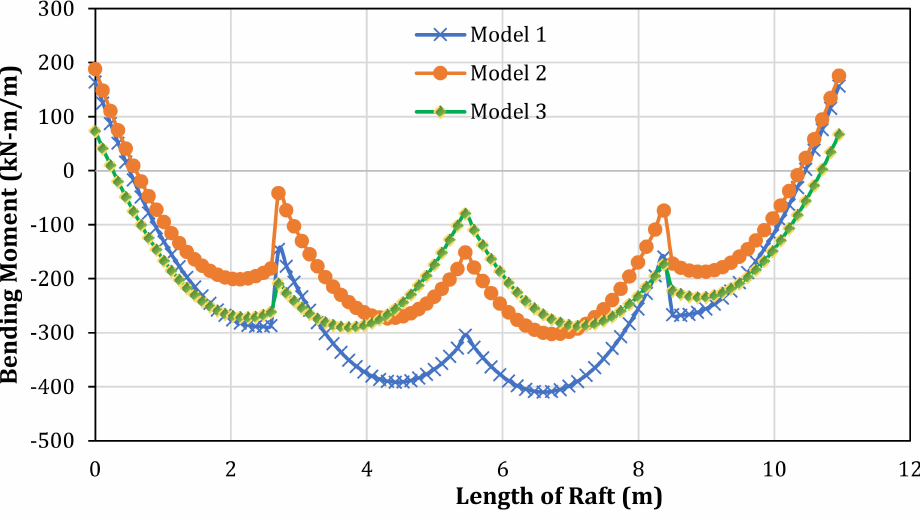
Figure 14. Bending moment variation profile along length of